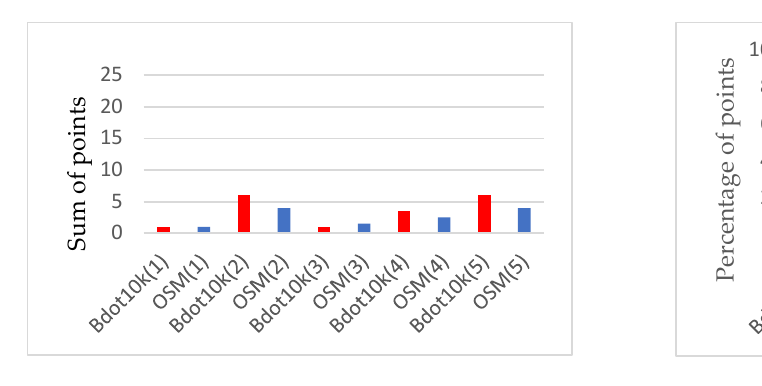
( b ) Figure 5. Usefulness of BDOT10k and OSM data — the second level of map detail: ( a ) sum of points; ( b ) percentage of points. For the second level of detail, a significant decline was observed in the category of geometry existence. For OSM, it was over 47%, while for BDOT10k, it was over 48%. This is due to the appearance of new objects, which are characteristic of a park but not present in the databases, such as antique elements or plant containers (urn, pot, crate, bucket, jar- dinière). At this level of detail, BDOT10k was considered to be better in three of the five categories. The total DUI of BDOT10k and OSM was lower than for the first level of map detail: 0.40 for BDOT10k and 0.39 for OSM.